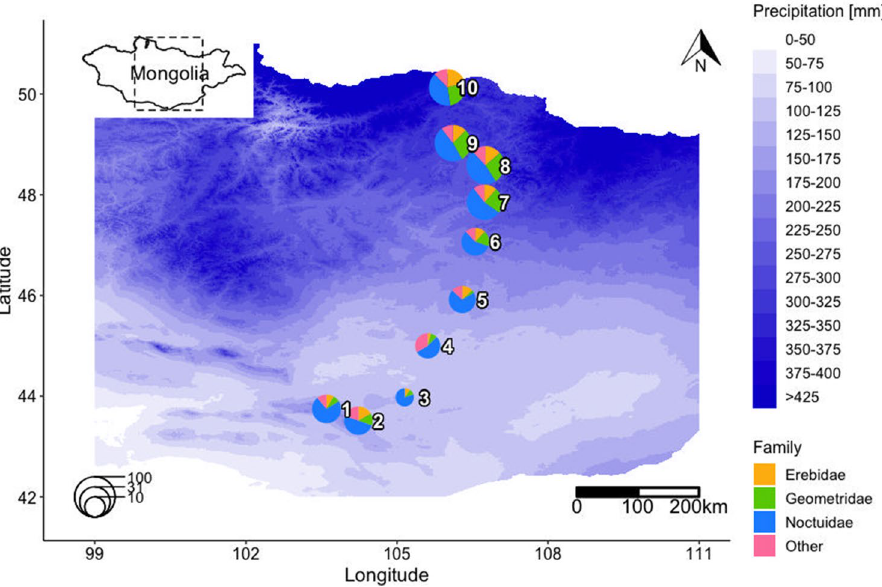
Figure 1. Study area with pie charts showing the percentage species composition of the main moth families: Erebidae, Geometridae, Noctuidae and all other families along the precipitation gradient. In group Other: These families are combined: Cossidae, Drepanidae, Lasiocampidae, Notodontidae, Sesiidae, Sphingidae, and Zygaenidae. Pie sizes correspond to species richness of the site (legend on the lower left side) See species richness and diversity of each site in Table S3 in supplementary material. Figure was produced using R software (version 3.6.3, R Core Team, https:// www.r- proje ct.